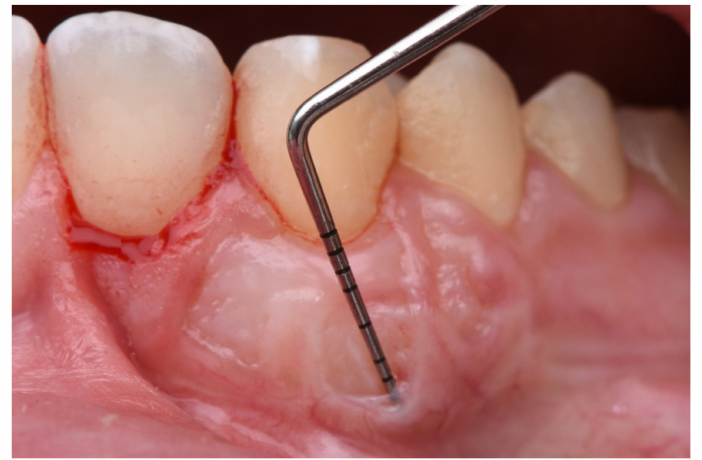
Figure 3. Cul de sac.